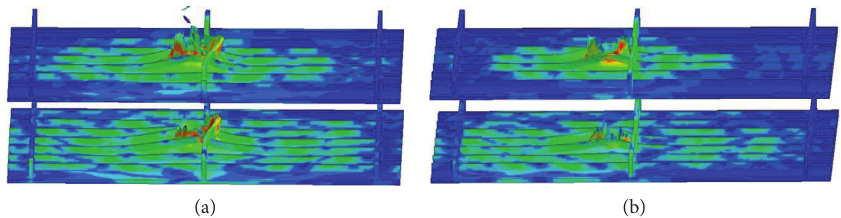
Figure 5: Target plate missile hole structure. (a) Working condition 5. (b) Working condition 6.